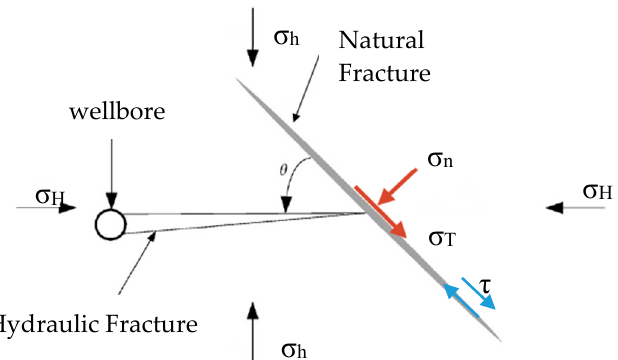
Figure 2. A schematic of a HF approaching a NF